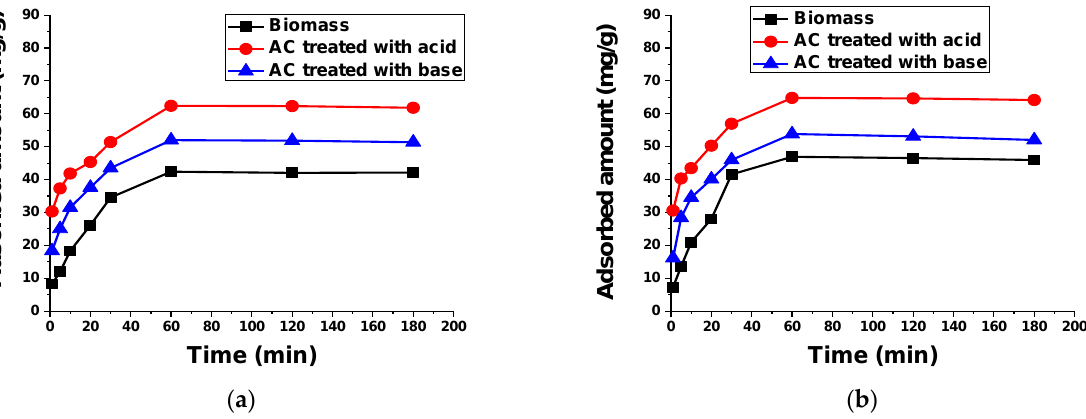
Figure 8. Effect of contact time on the adsorption of 50 mL ( a ) 100 mg/L TB and ( b ) 50 mg/L XO using 0.1 g biomass and AC treated with acid and base at 140 rpm and room temperature.